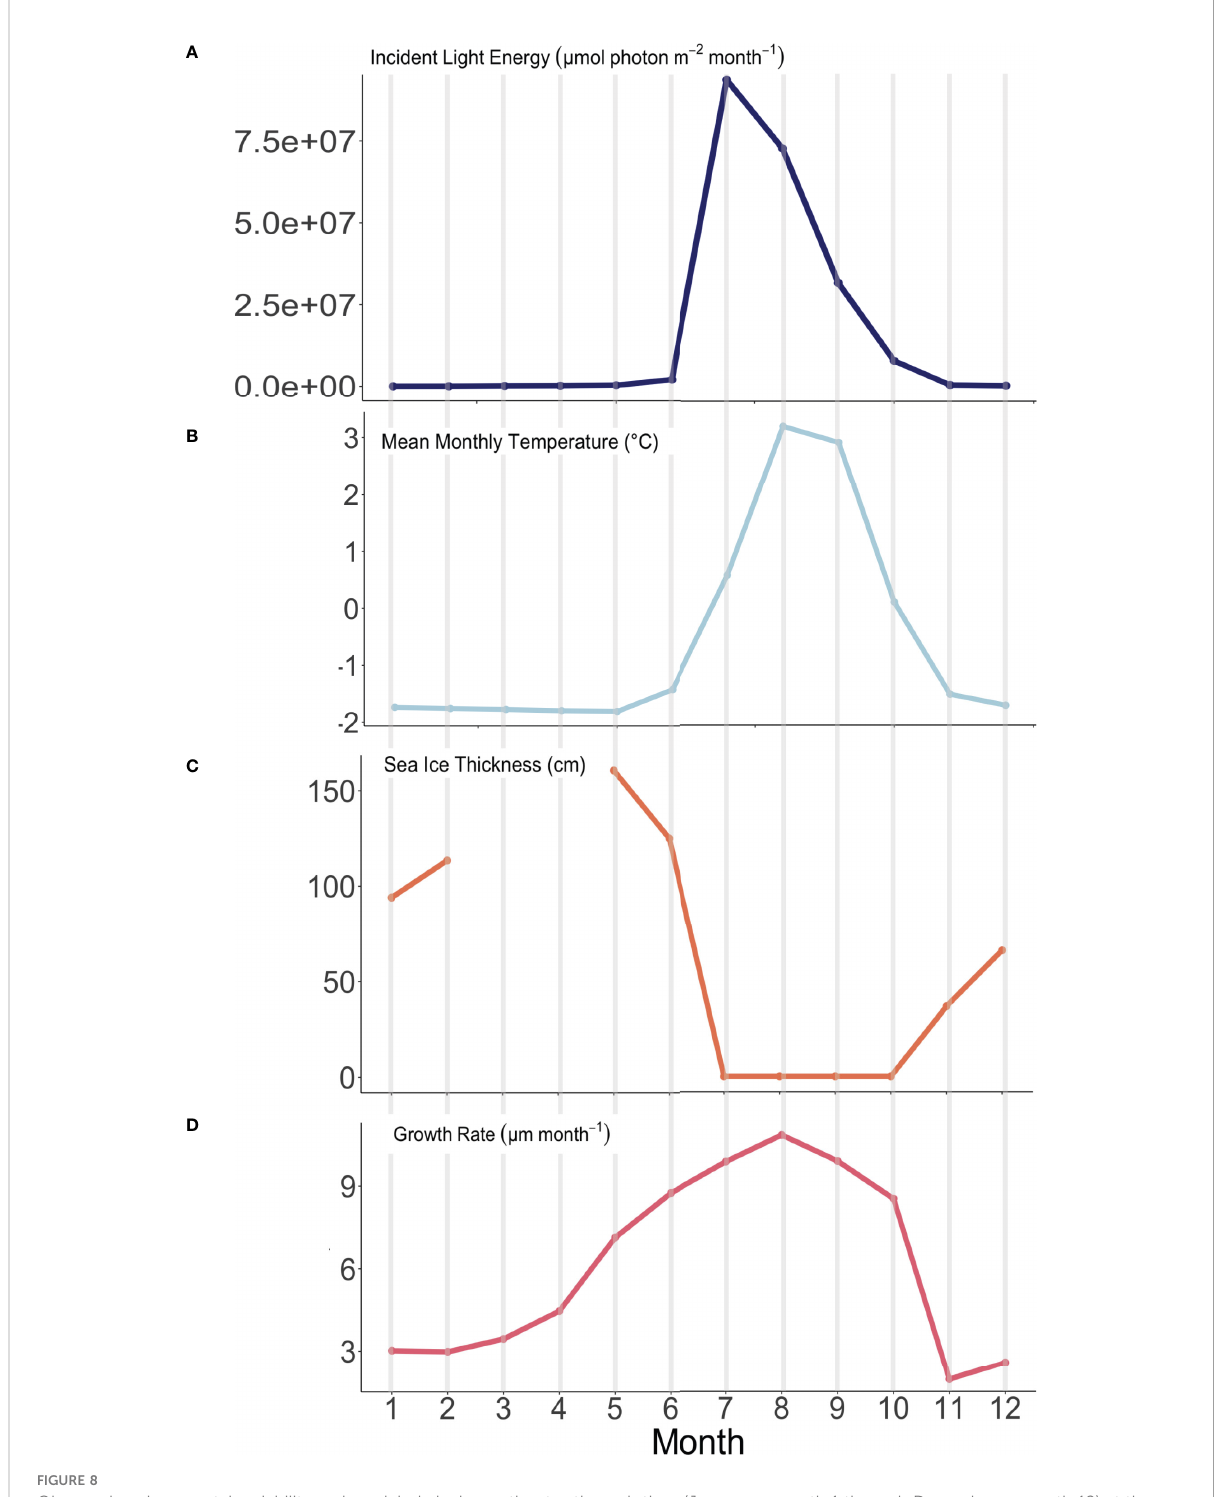
FIGURE 8 Observed environmental variability and modeled algal growth rates through time (January – month 1 through December – month 12) at the experimental array in Arctic Bay, NU. (A) Incident light energy (µmol photon m -2 month -1 ), (B) Average monthly temperature (°C), (C) sea-ice thickness (cm), and (D) modeled algal growth rate (µm month -1